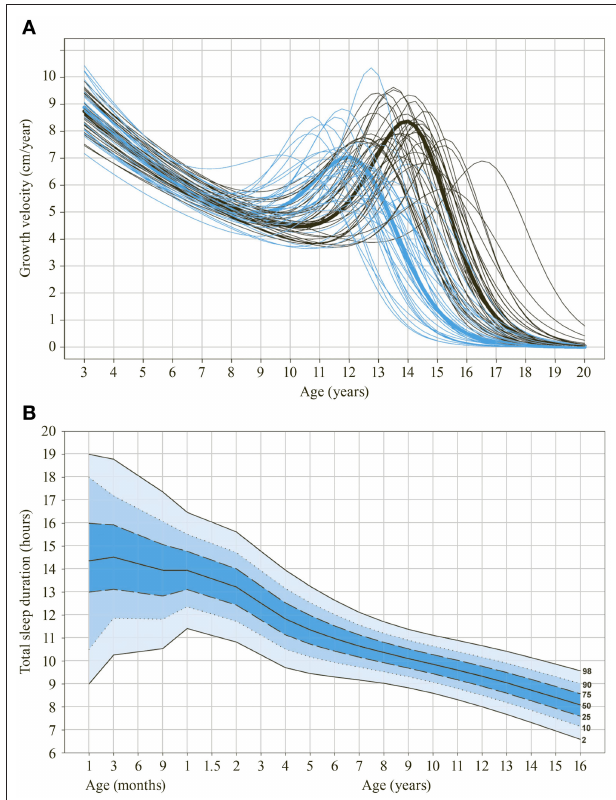
FIGURE 1 | Selected findings derived from ZLS-Childhood data. (A) Growth velocity (in cm/year) of individual participants of the first ZLS cohort between 3 and 18 years of age using spline functions and kernel estimation. Blue lines indicate girls, black lines indicate boys. Thick lines indicate group means. (B) Reference chart on sleep duration between 3 months and 16 years of age. Data is derived from the second and third ZLS-cohorts (see also Iglowstein et al.,